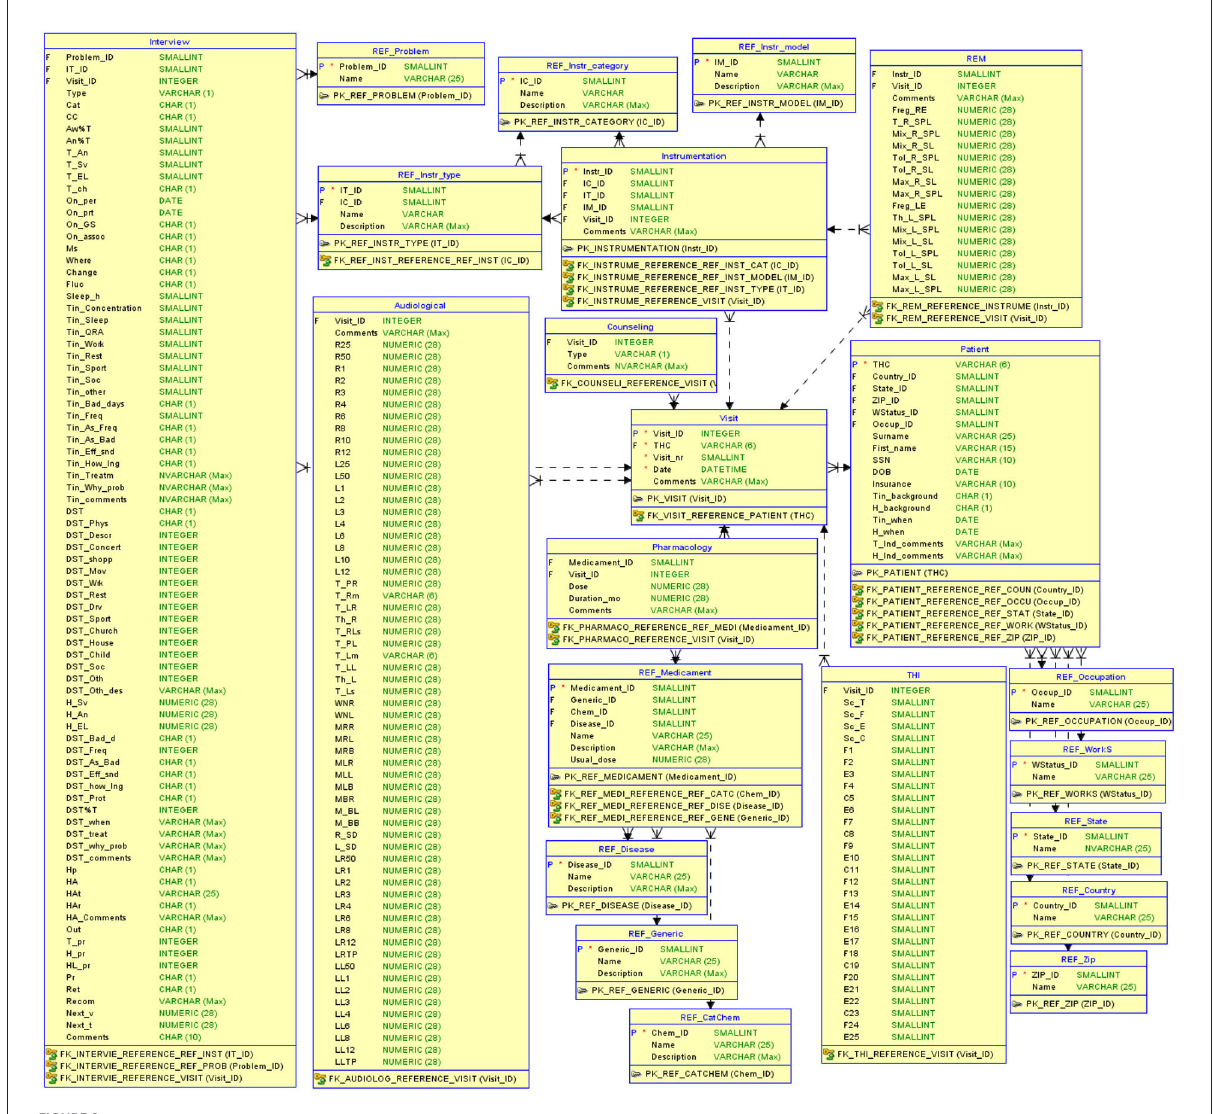
FIGURE2 The relational database structure to store tinnitus-related